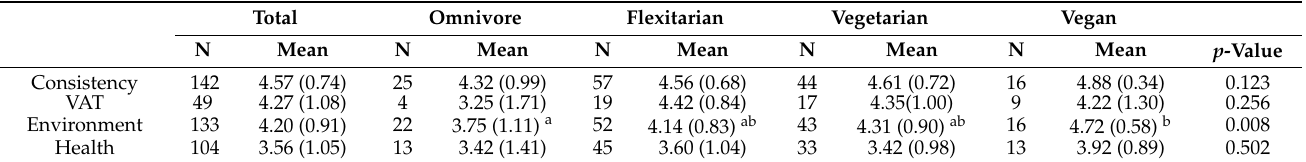
Table 12. Mean scores and standard deviation of the objective knowledge about sustainability characteristics of PBMiAs 1 by participants’